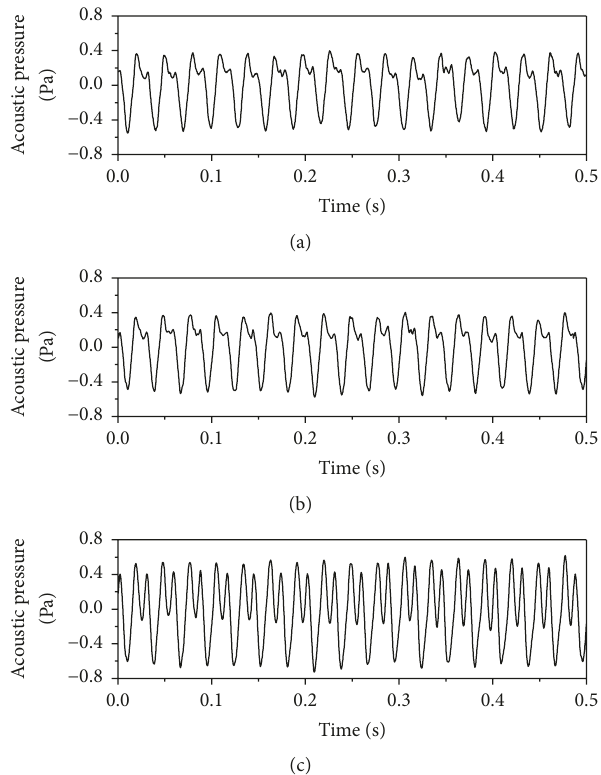
Figure 4: Comparison between (a) measured engine sound and (b) synthesized engine sound. The mechanical sound was varied by adjustingtheamplitude(theamplitudesatfrequencies2 𝑓 0and10 𝑓 0 were amplified 2 and 10 times and are shown in